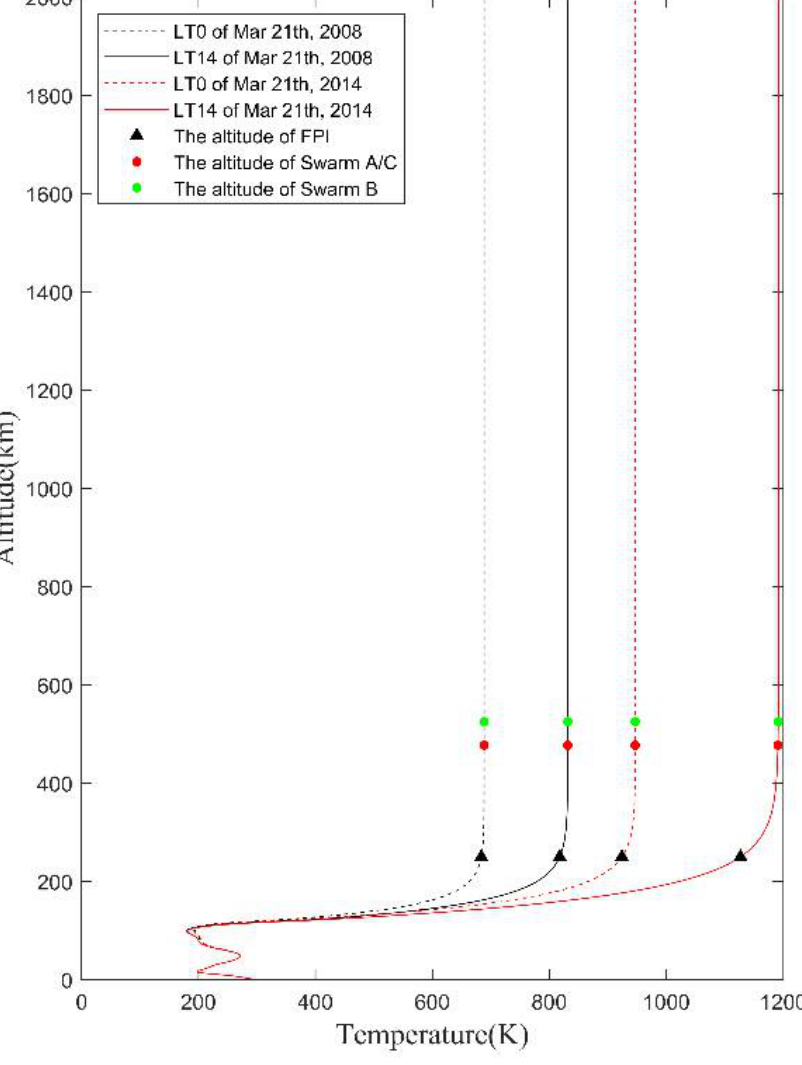
Figure 2. Variation of daytime and nighttime neutral temperatures with altitudes in 2008 and 2014. The green dots are the temperature of Swarm B, the red dots are the temperature of Swarm A and Swarm C, the black triangles are the temperatures at FPIs’ altitude.